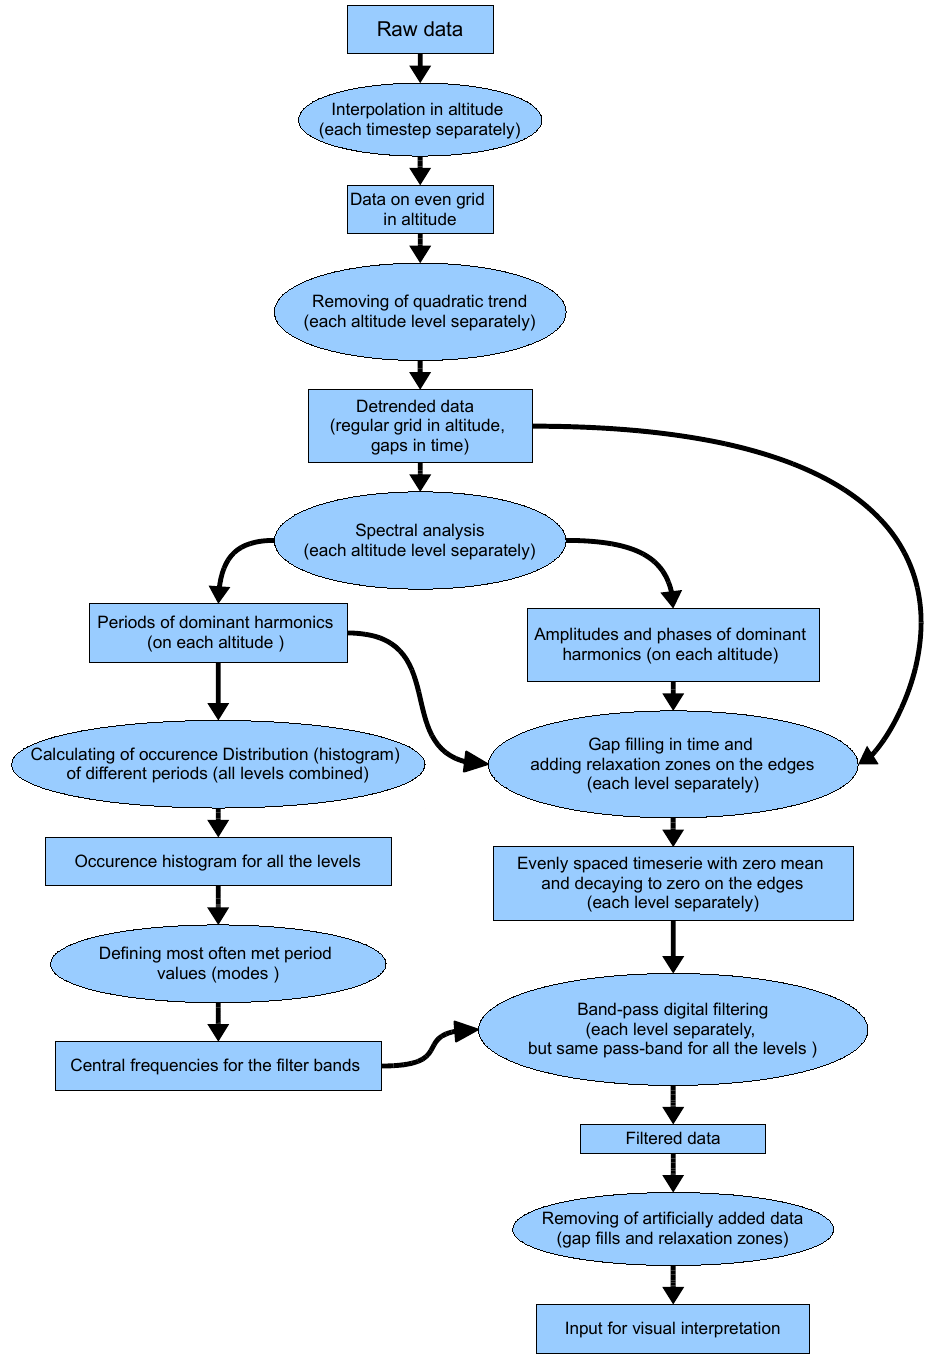
Fig. 2. The flow-chart of the automatic part of analysis. Software modules are represented by ovals. Rectangular boxes describe the input/output data of individual software